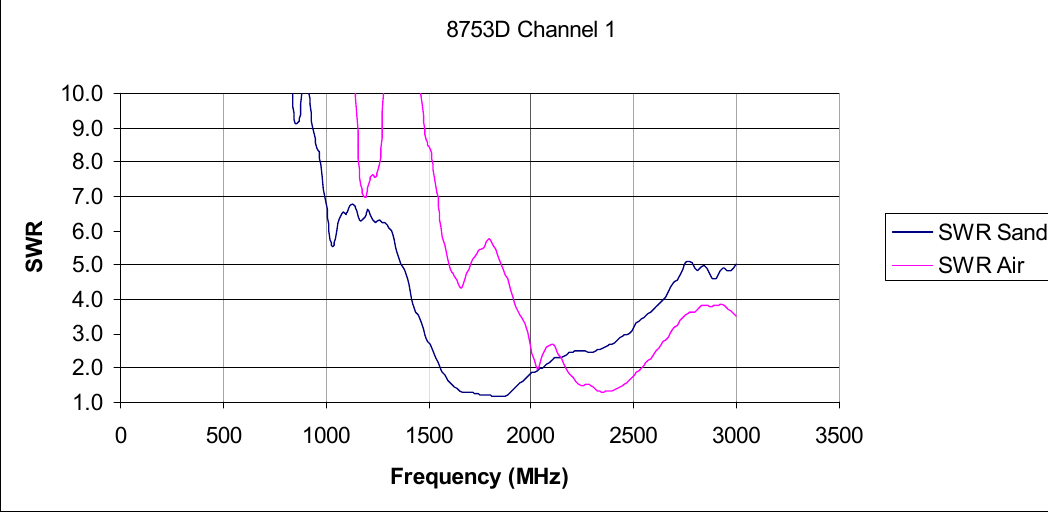
Figure 5. SWR comparison plot of quarter-wave insertion probes showing resonance locations for dry sand and air. Of particular note is the decrease in the resonant frequency that occurs as the permittivity of the material surrounding the TDR probe increases. 8753D Channel